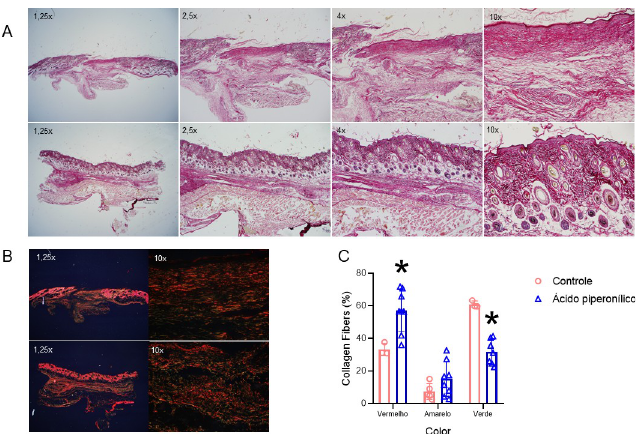
Fig 3. Microscopic aspects of the wounds. Microphotograph of hematoxilin/eosin staining of 5.0 μ m sections of wounds on day 19. Arrows showing vessels, hair follicle and papillae structure (A). Collagen deposition stained by picrosius red on day 19 (B). Determination of type I and type III collagen fibers by optical density of red, yellow, and green values (C). � p < 0.05. The images are representative of five distinct experiments.